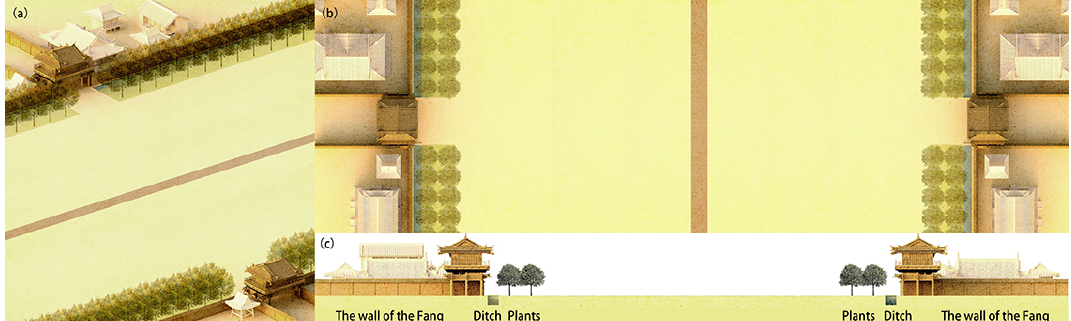
Figure 12. ( a ) Diagram of the streets outside the Fang near the Fang Gate in Chang’an, ( b ) top view, ( c ) section view. The visual integration within the eastern and western markets were calculated (Figure 13).